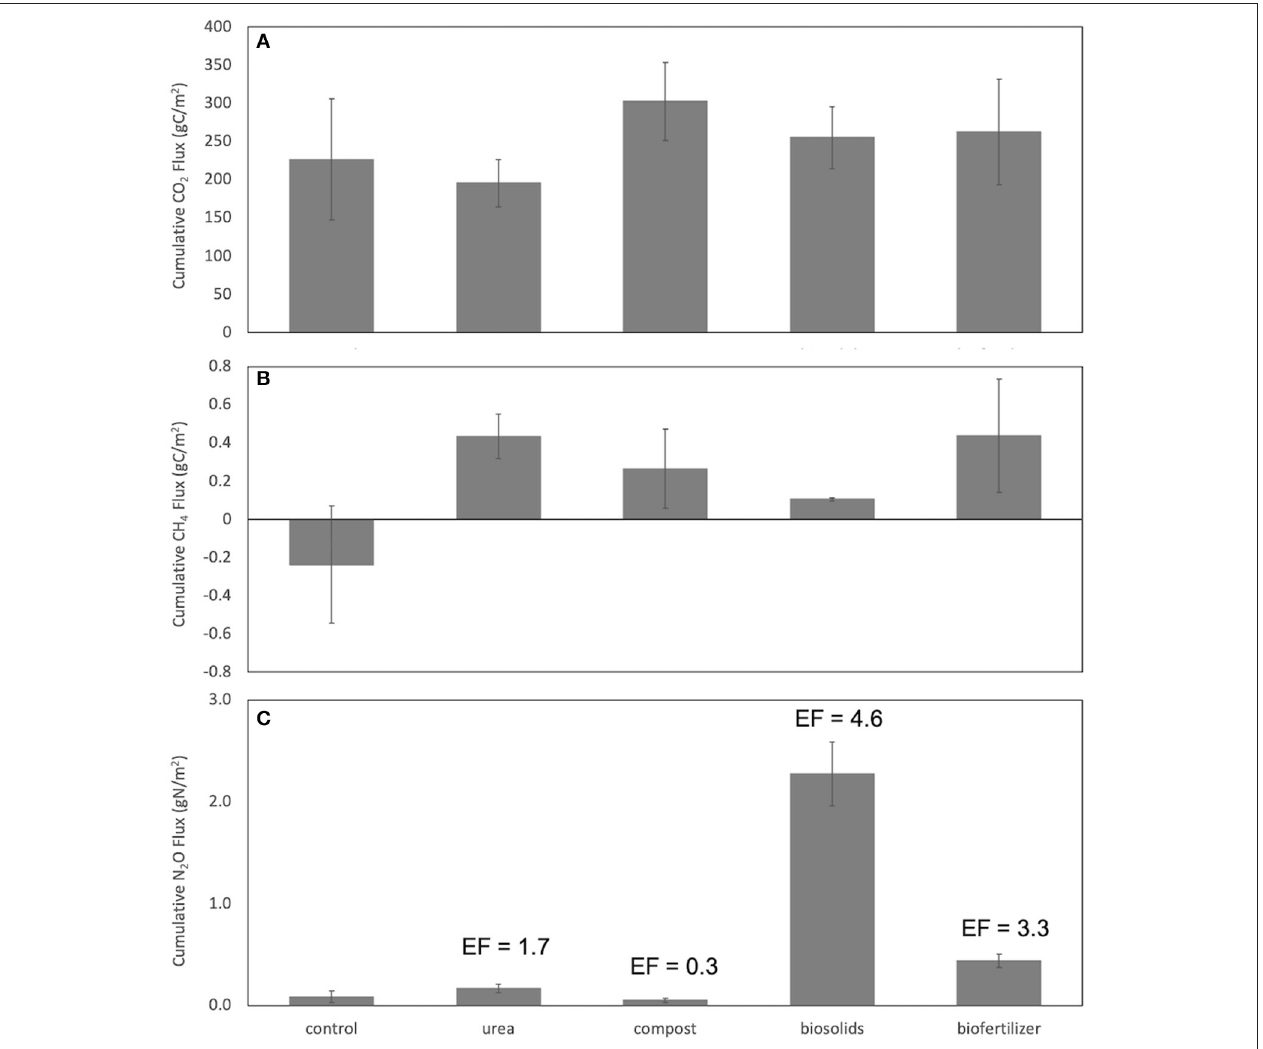
FIGURE 6 | Cumulative soil emissions of (A) CO 2 , (B) CH 4 , and (C) N 2 O during the first two crop cycles from days 1 through 73. Bars represent treatment means. Error bars indicate ± standard error. EF indicates treatment N 2 O emissions factors, calculated as the percent of total N added lost as gaseous N 2